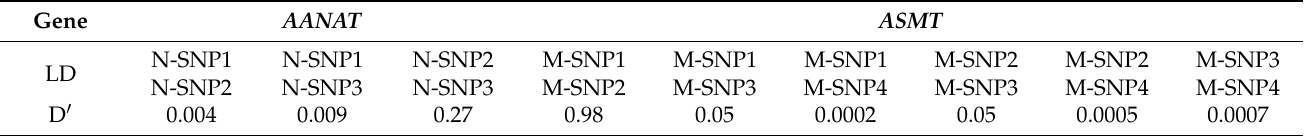
Table 3. Linkage disequilibrium (LD) analysis of seven SNP loci within the cow AANAT and ASMT